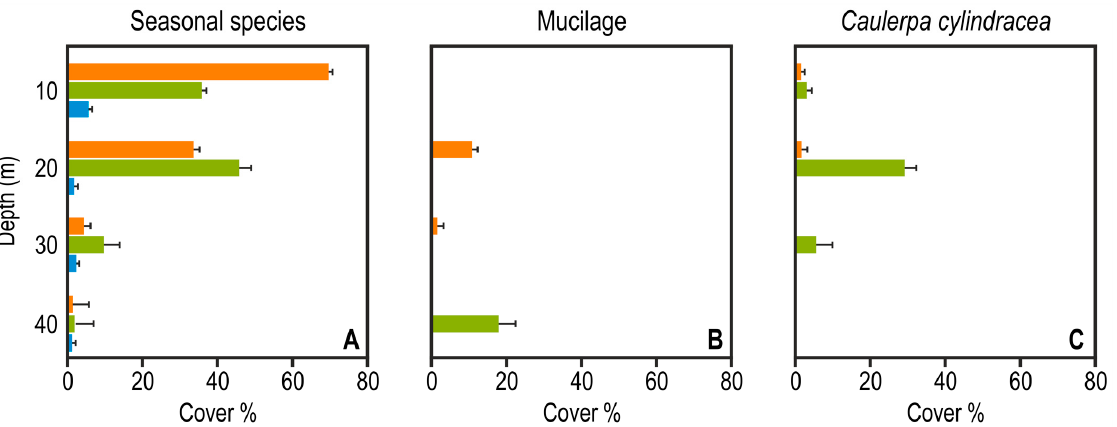
Figure 7. Percent cover (+ se) of ( A ) seasonal species, ( B ) mucilage, and ( C ) Caulerpa cylindracea at the three times (June in orange, October in green, December in blue) at the four depths surveyed (10 m, 20 m, 30 m, and 40